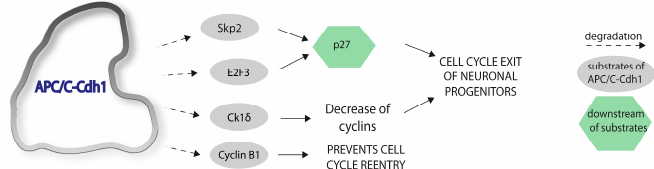
Figure 2. APC/C-Cdh1 regulates neurogenesis and cell cycle exit. Various substrates of APC/C-Cdh1 have been shown to be involved in the regulation of the cell cycle of neuronal progenitors: Skp2, E2F3A, Ck1 δ . Cyclin B1 downregulation is responsible for maintaining the cell cycle